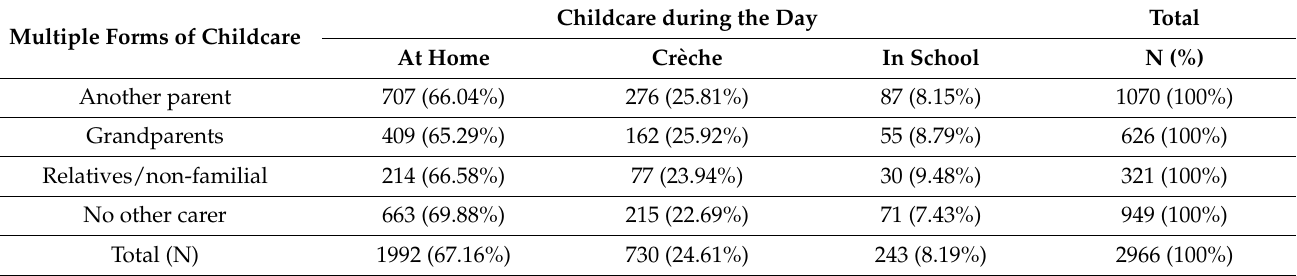
Table 3. Proportion, with percentages, of children cared for during the day and experiencing multiple forms of